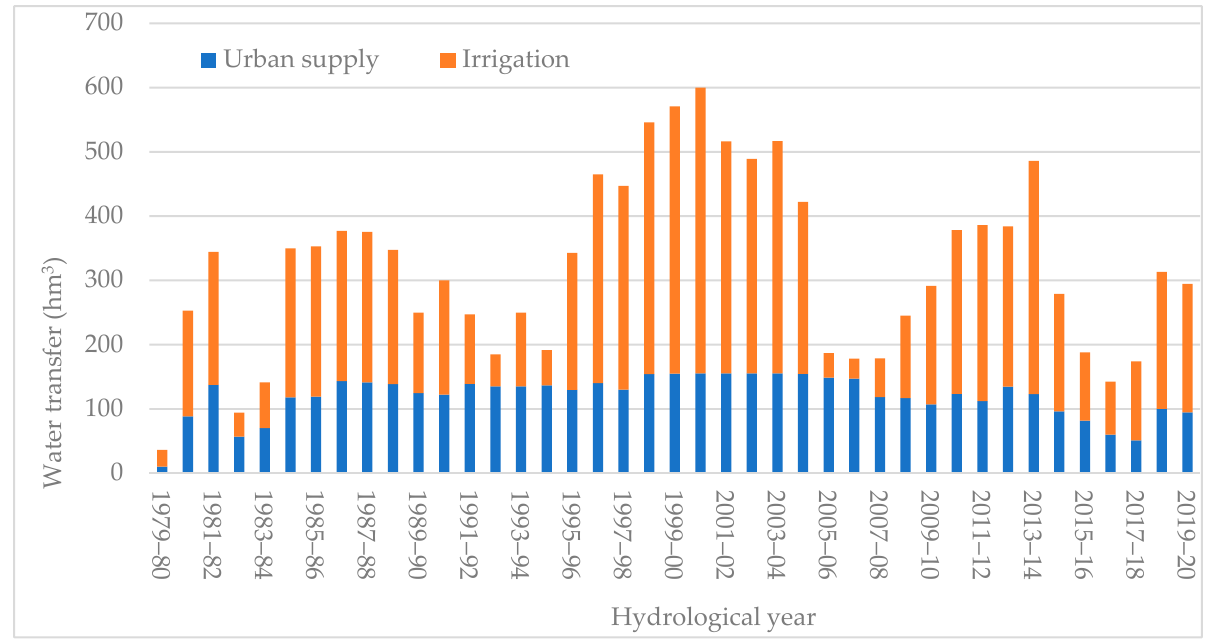
Figure 2. History of water transfers (hm 3 ) to south-eastern Spain up to hydrological year 2019–2020. Source: [36].